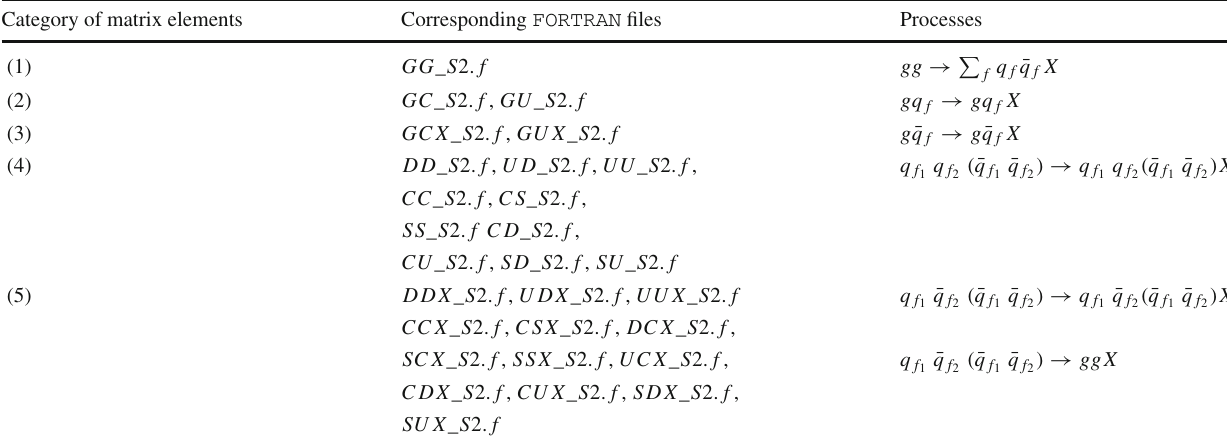
Table1 Listofimplementedprocessescontributingtothespin-2Xparticleproduction,groupedintocategorieswhichdifferbyflavoursofincoming partons. For each category, the names of FORTRAN files calculating squared matrix elements, for given flavour configuration of incoming partons, are given in the second column. Examples of processes in each category are given in the last column Category of matrix